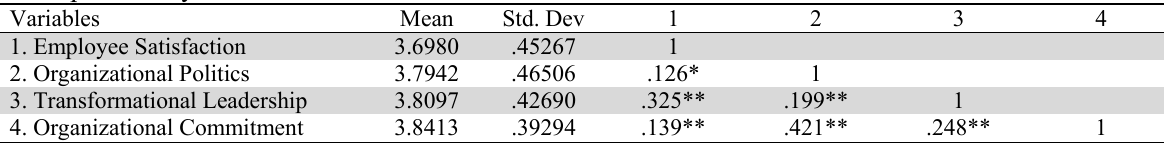
Descriptive analysis